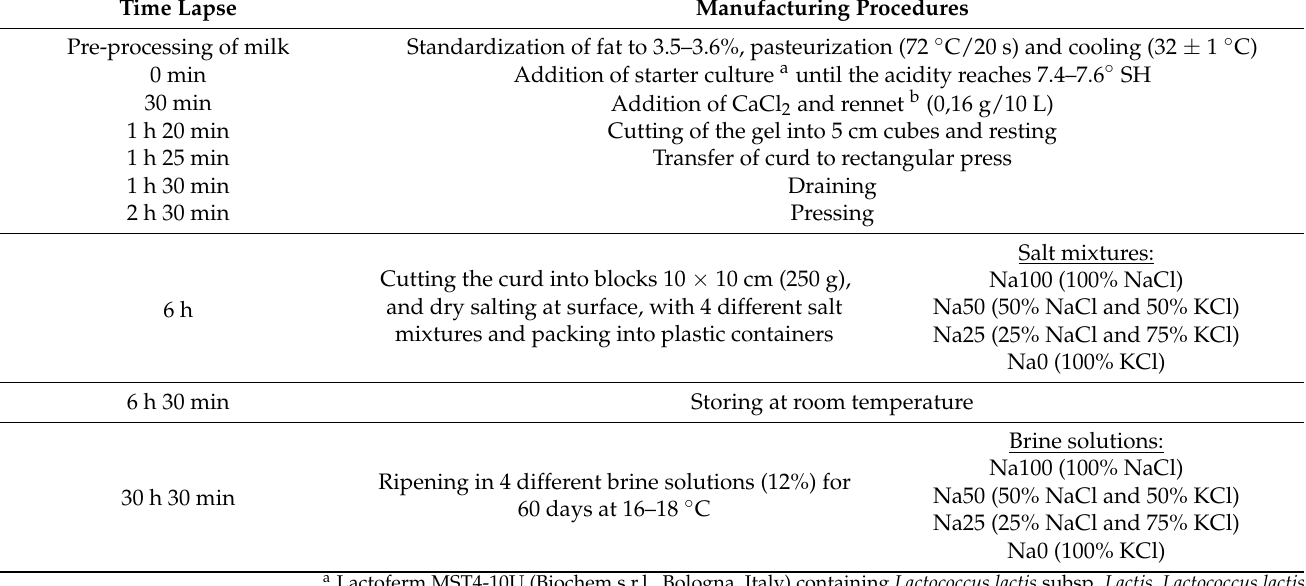
Table 1. Production process for Serbian white brined cheese—Homoljski Sir. Time